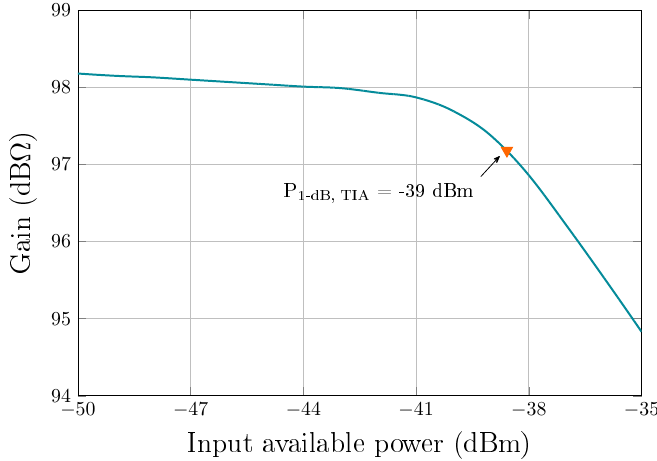
Figure 10. Measured TIA gain for different input power levels, outlining the 1-dB compression